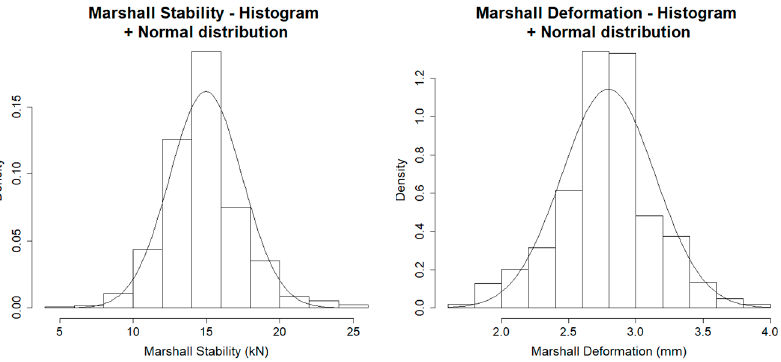
Figure 10. Histogram and normal distribution curve of stability indicators.